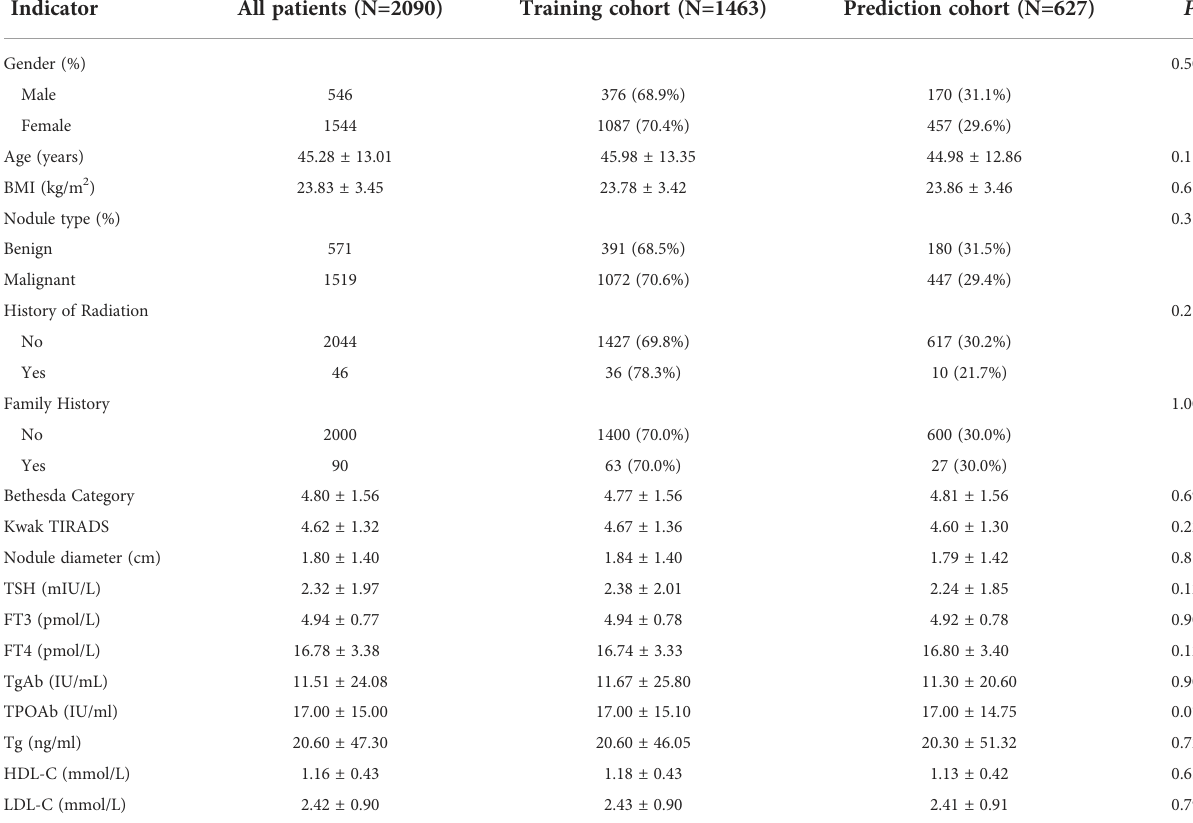
TABLE 4 Baseline characteristics of TN patients in the training and prediction